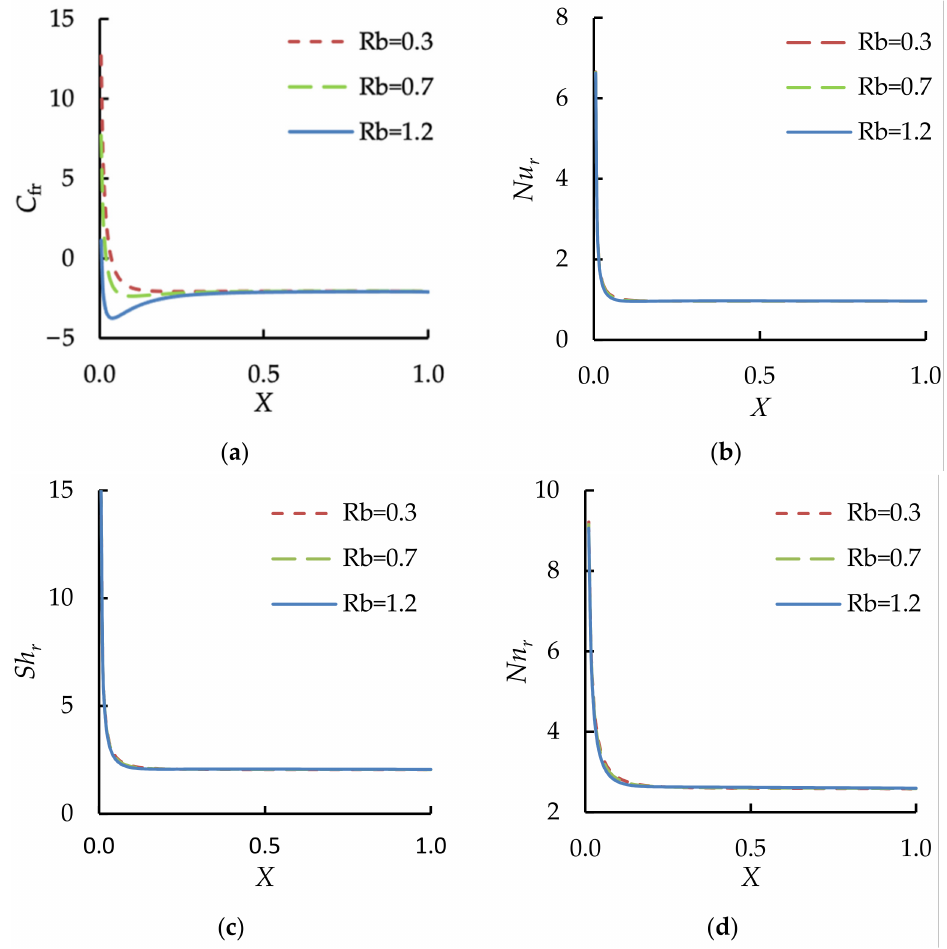
Figure 14. Effects of the bioconvection Rayleigh number, Rb , on ( a ) the reduced skin friction co- efficient, C fr , ( b ) the reduced Nusselt number, Nu r , ( c ) the reduced Sherwood number, Sh r , and ( d ) the reduced concentration of microorganisms, Nn r , when Re = 200, Gr = 4 × 10 4 , Pr = 6.2, Le = 10, Nb = Nt = Nr = Ω = 0.1, and Lb = Pe = 1.